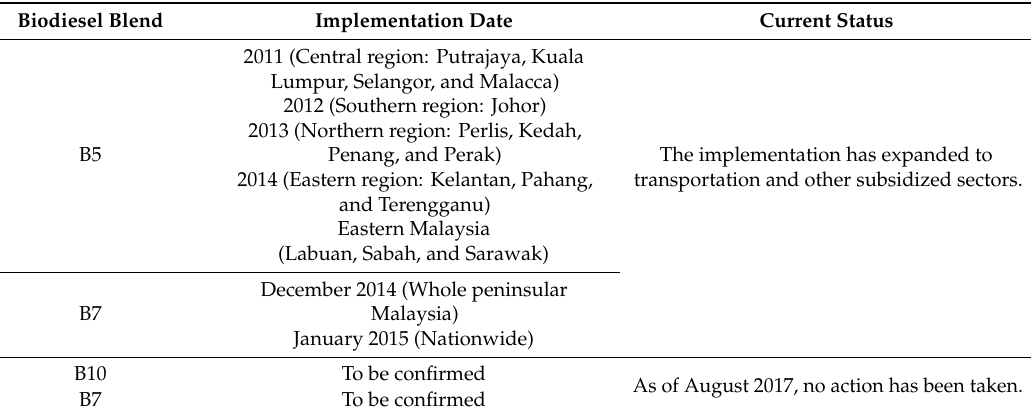
Table 3. Status on the biodiesel implementation in Malaysia.